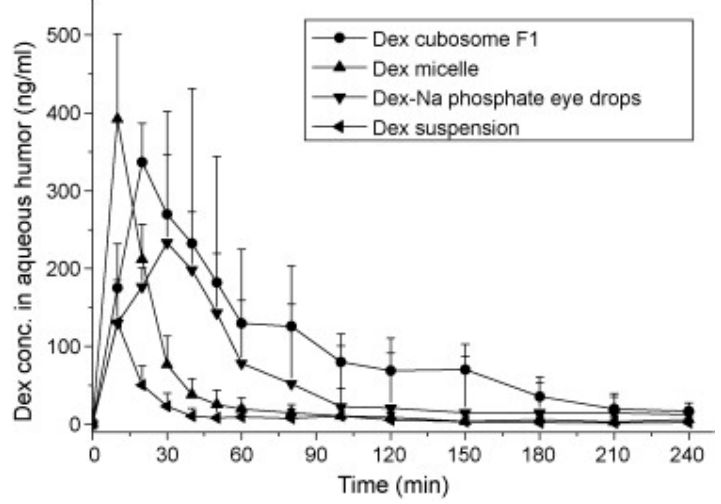
Figure 6. Concentration-time profile of Dexamethasone (Dex) in the aqueous humor of rabbit after the instillation of various formulations